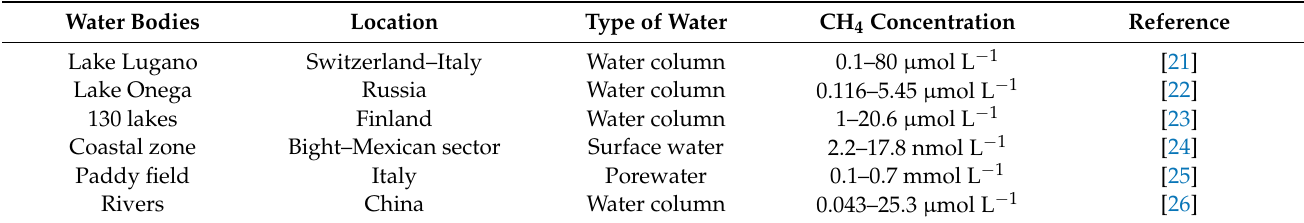
Table 1. CH 4 concentrations in different natural water